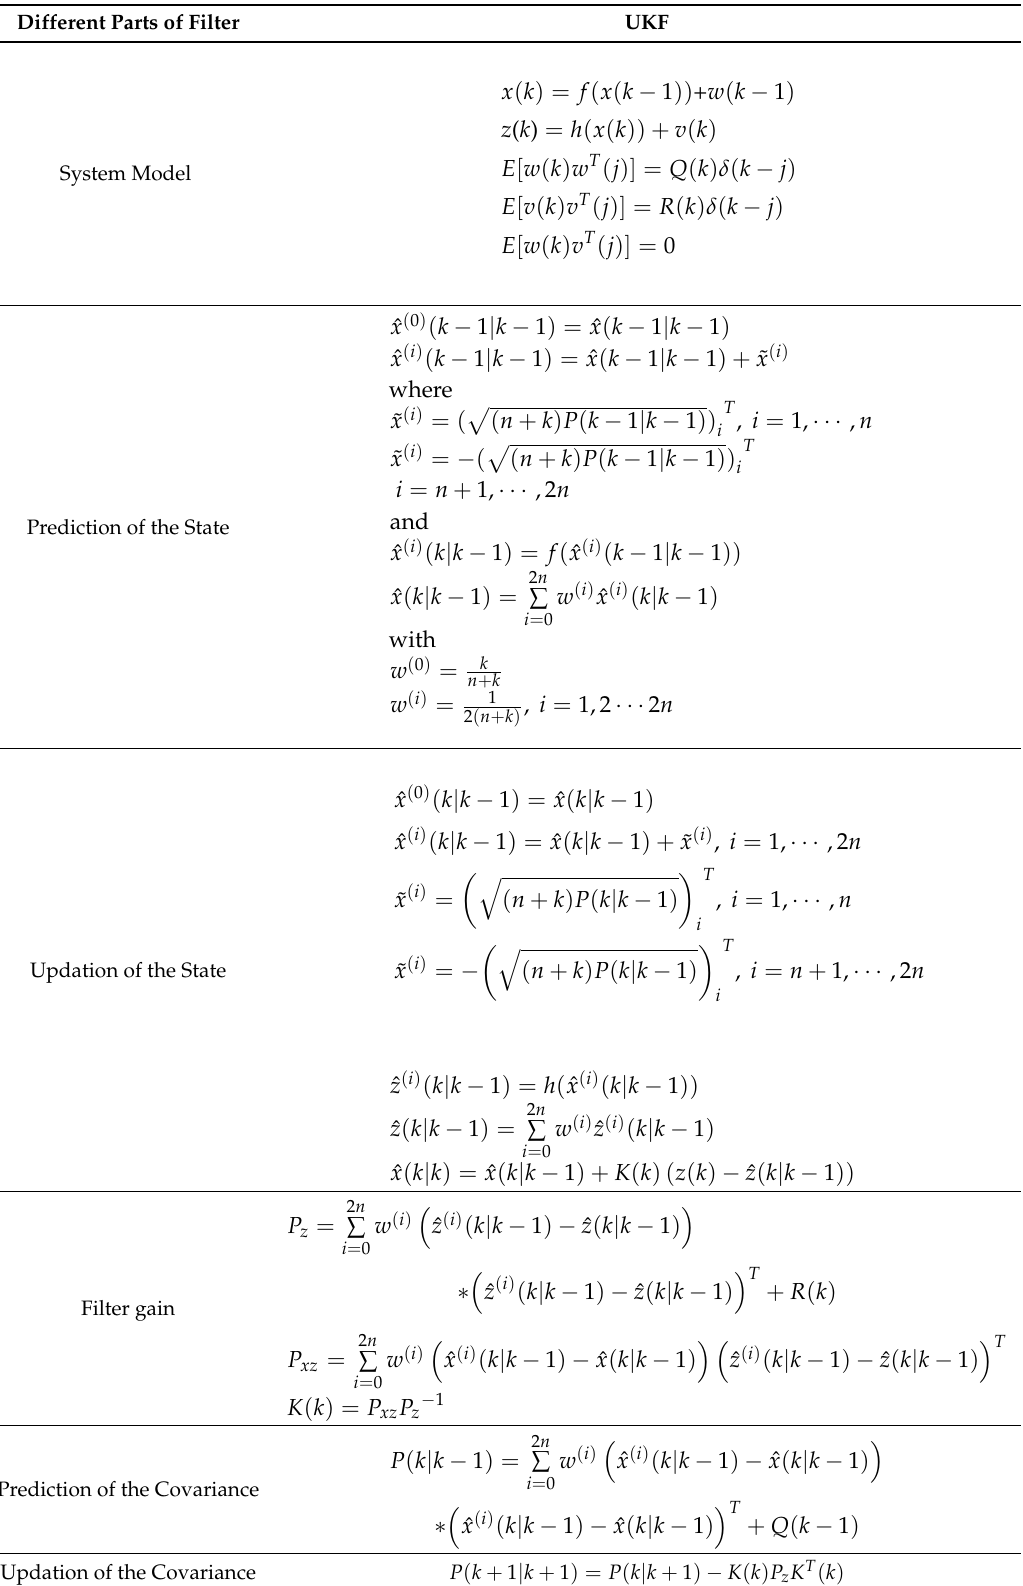
Table A2. The details of